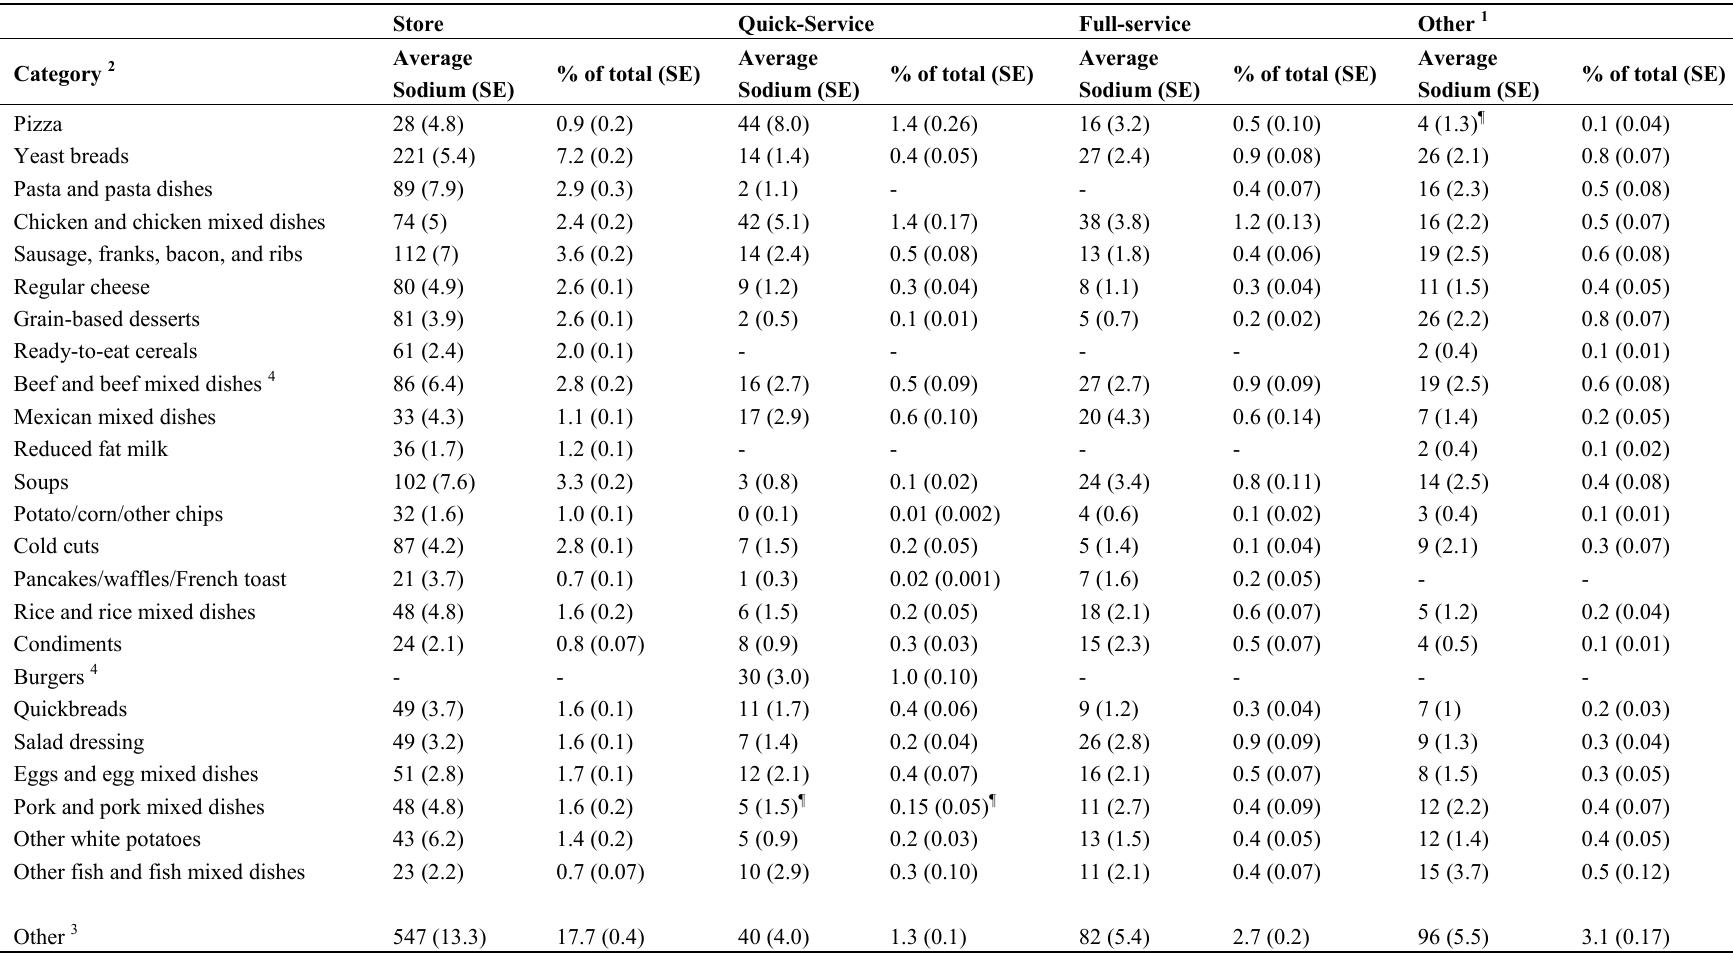
Table 5. Contribution to total sodium intakes from specific food sources by eating location for adults (≥51 years), NHANES